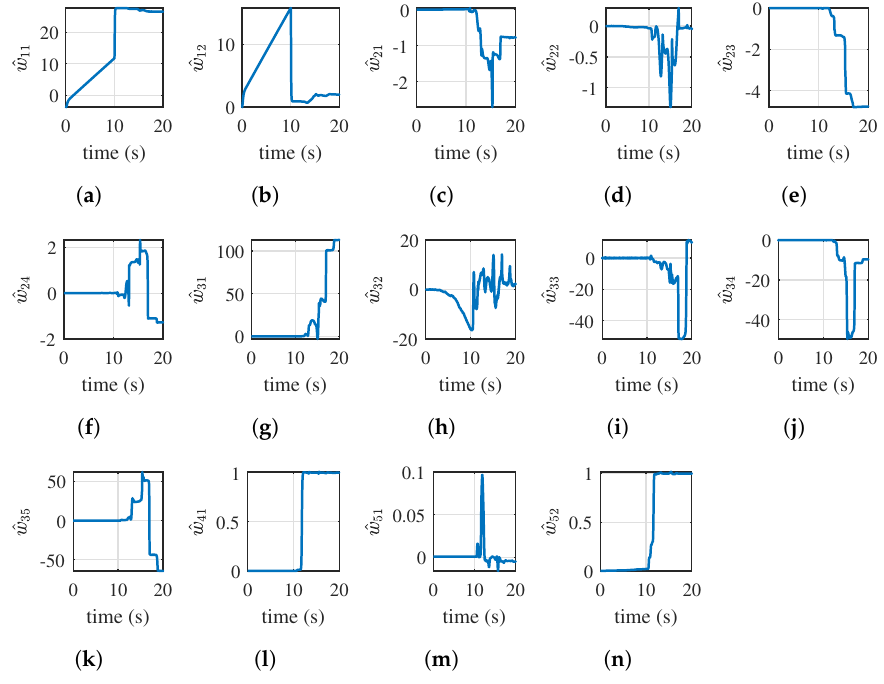
Figure 13. Synaptic weights of the neural identifier (24). The parameters used in the observer (5), neural identifier (24) and inverse optimal controller (27) are listed in Table